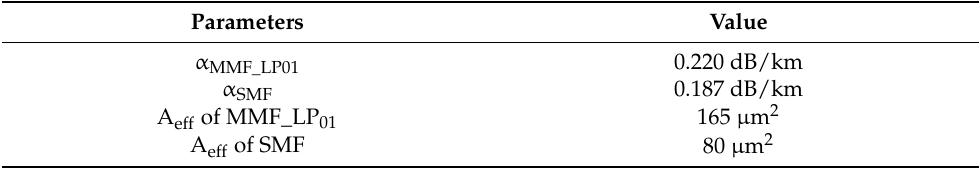
Figure 3. The back-scattered optical power versus input optical power for ( a ) a 10-km SMF and an 8.8-km MMF and ( b ) a 16.2-km SMF and 17.6-km MMF with and without adapters. Table 1. The performance characteristics of the SMF and OM3